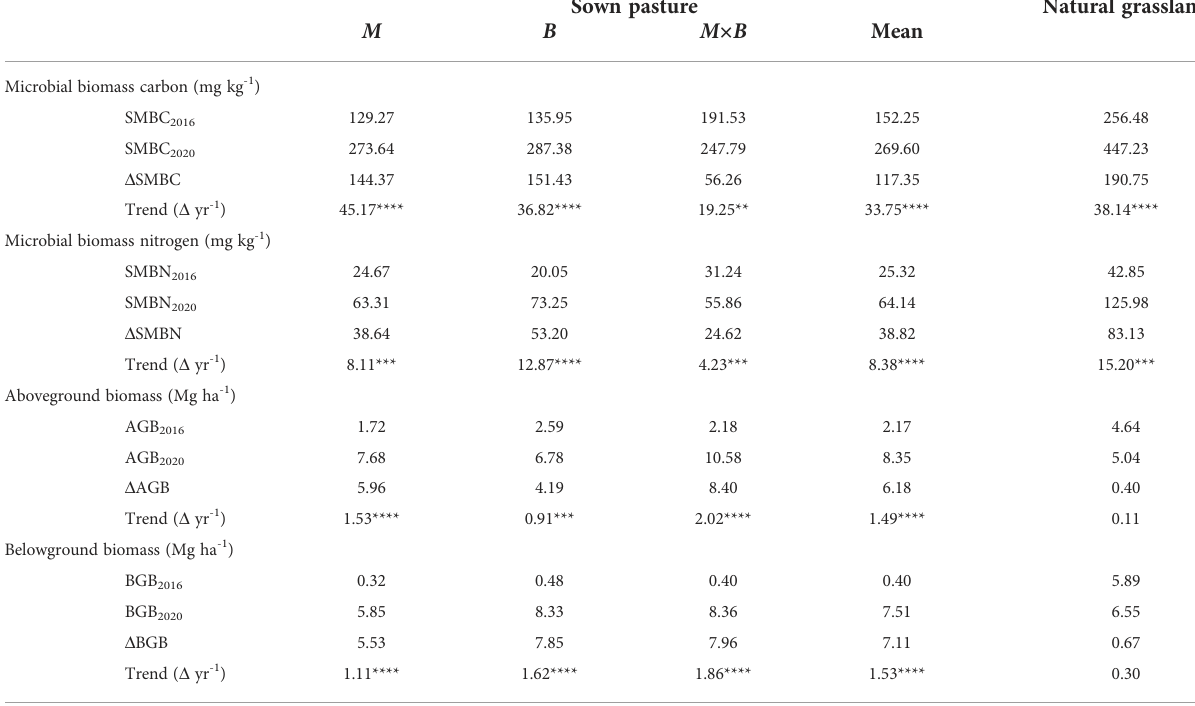
TABLE 2 Temporal variations and trends in the biological properties of soils under sown pastures versus the natural grassland from 2016 to 2020. Sown pasture